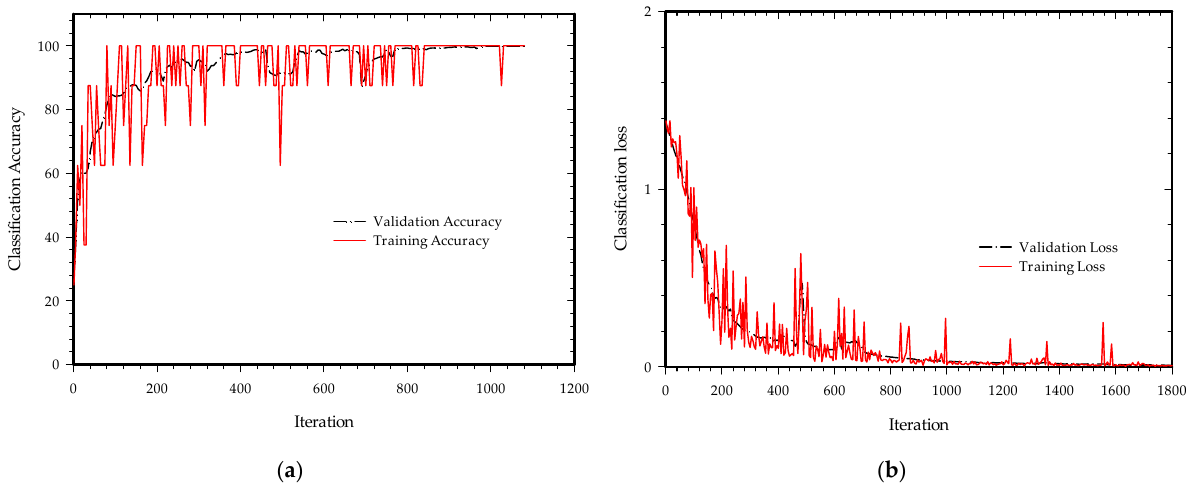
Figure 10. Training progress with 25 epochs: ( a ) Classification accuracy; ( b ) Classification loss. The Confusion Matrix for the suggested sleeping body states recognition framework is shown in Figure 11. Each body state categorization accuracy is displayed diagonally in green, while the error values are displayed in light red. As we can see, the sleeping state of the body to the right, middle and empty bed positions create significantly less varied states in comparison to the left side, indicating a higher level of accuracy. Compared to the left, middle, and right bed states, the empty bed state position has been more predicted than its true state.